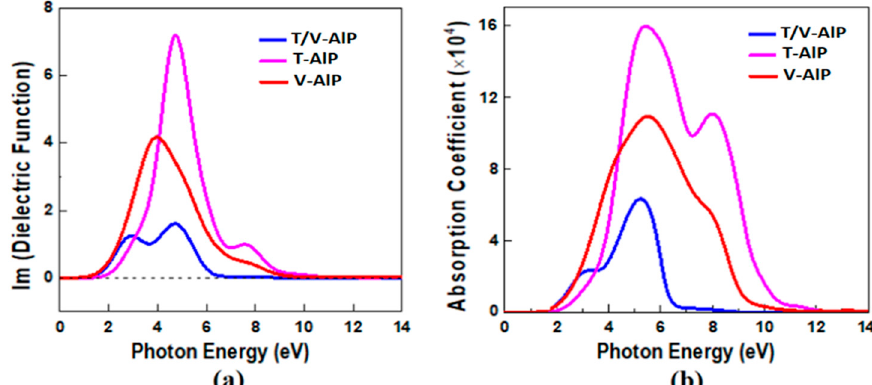
Figure 9. ( a ) The imaginary dielectric function; ( b ) the absorption spectra of the AlP bilayers. Curves of different colors represent the optical spectra of the different types of AlP bilayer materials.